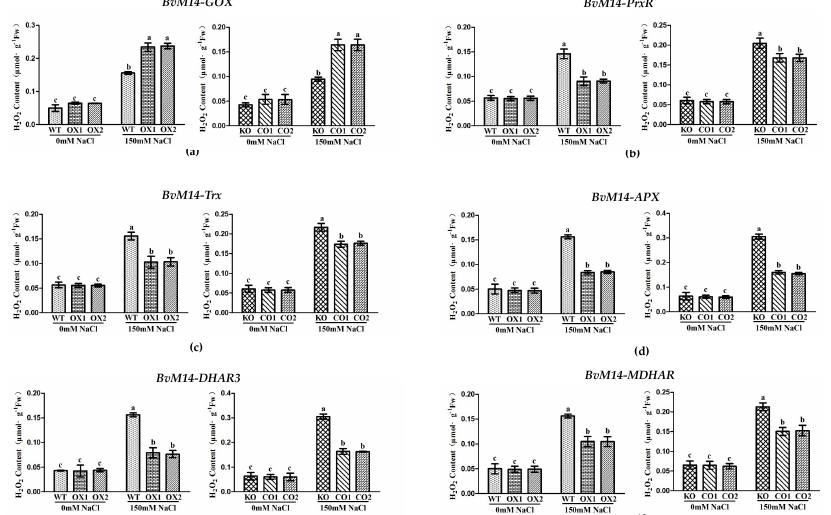
Figure 3. H 2 O 2 contents of WT and GOX , PrxR , Trx , APX , DHAR3 , and MDHAR transgenic plants under salt stress: ( a ) GOX -related plants; ( b ) PrxR -related plants; ( c ) Trx -related plants; ( d ) APX - related plants; ( e ) DHAR3 -related plants; ( f ) MDHAR -related plant. Data were analyzed by Duncan’s analysis of variance, and different lowercase letters (a, b, c) indicate differences in H 2 O 2